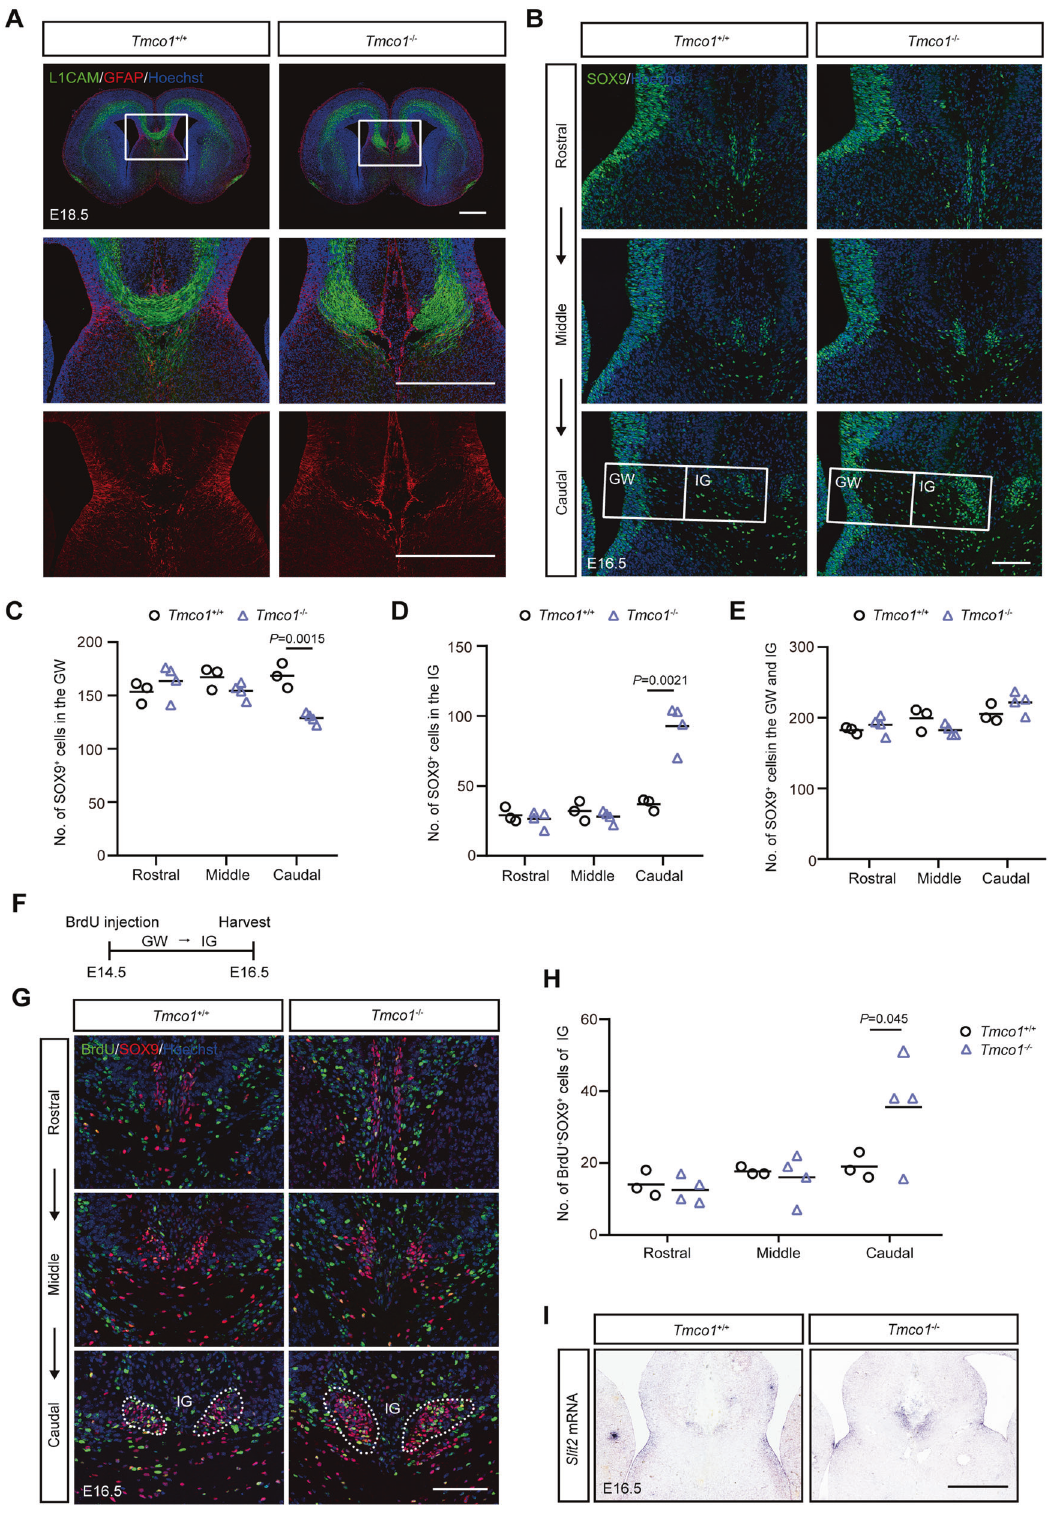
TMCO1 de fi ciency did not alter the expression and distribution of all markers, indicating that CPNs were speci fi ed correctly (Fig. S2A and S2B). Neurite outgrowth is crucial for neural and corpus callosum development [41, 42]. In the preparatory phase of the corpus callosum formation, there was no signi fi cant difference